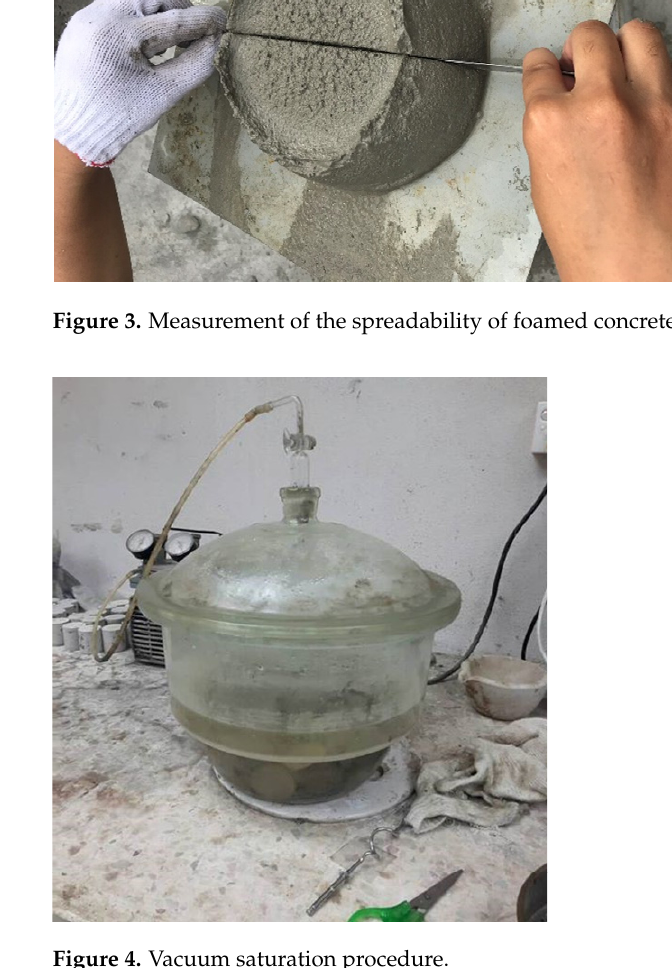
Figure 3. Measurement of the spreadability of foamed concrete.